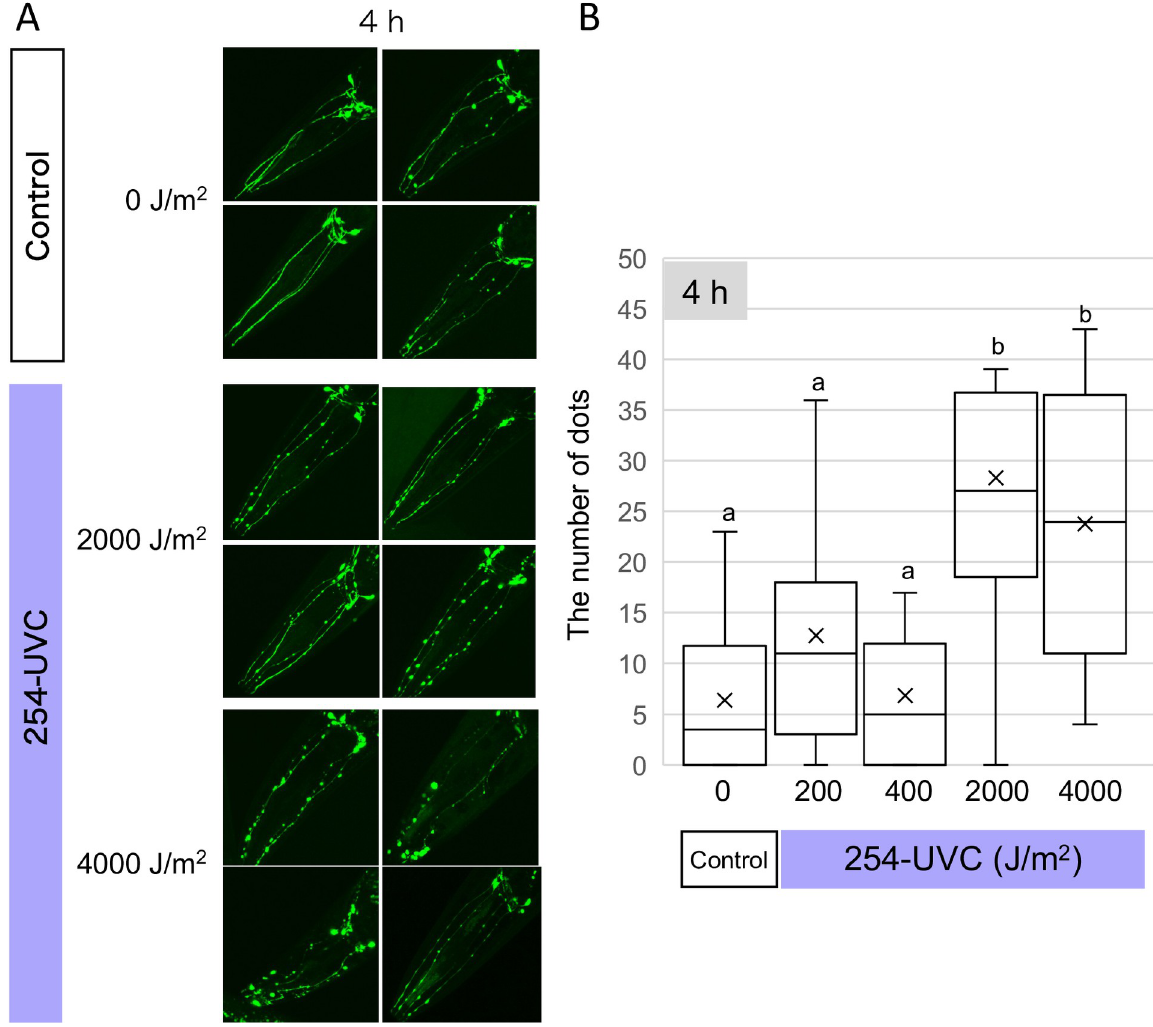
Fig 8. Dopaminergic neurons degenerate upon strong 254-UVC exposure. (A) Representation of damage in dopaminergic neurons after UVC exposure. 3D reconstruction of confocal fluorescence from head dopamine neurons in a p dat-1 ::GFP transgenic line (TG2435). GFP-labeled dopaminergic neurons were observed 4 h after 254-UVC exposure (2000 and 4000J/m 2 ). (B) The number of GFP dots along CEP dendrites in the head zone. GFP dots were counted by looking with adding the mark on the pictures opened by ImageJ software. Box plots show minimum, 25th percentile, median, 75th percentile, and maximum. a and b indicate a significant difference between indicating two groups (one-way ANOVA followed by Dunnett’s method) ( P < 0.05).